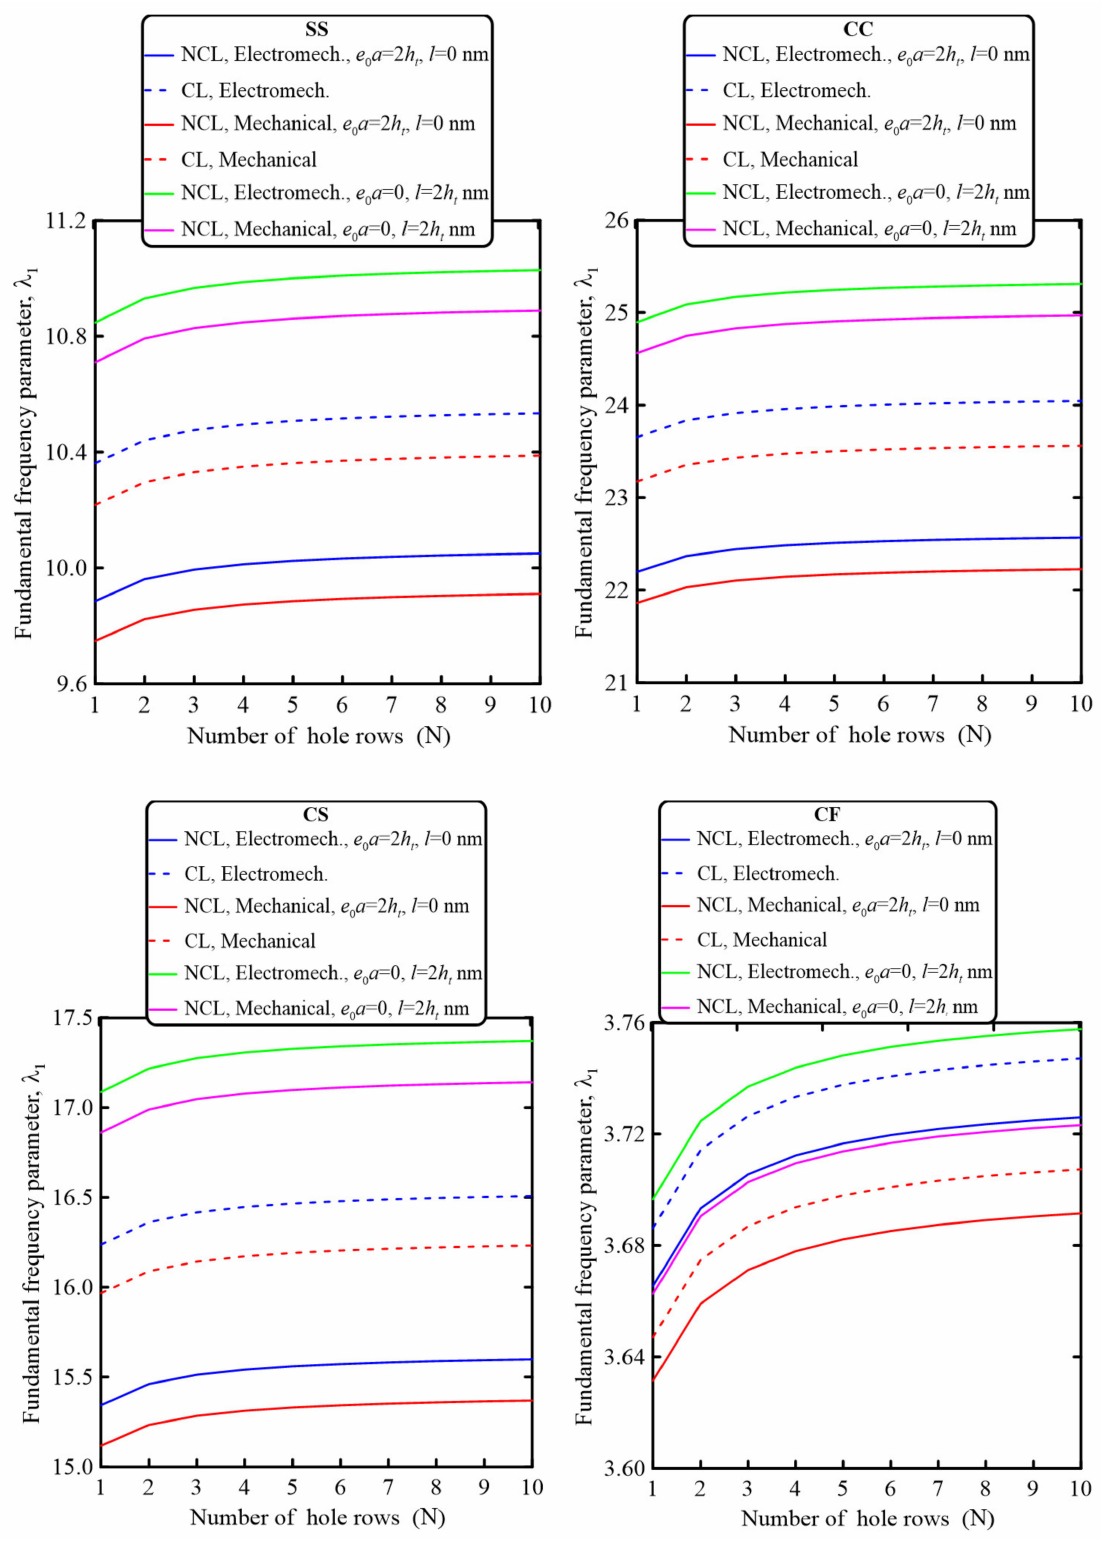
Figure 3. Variation of the fundamental frequency parameter λ 1 with the number of hole rows N for nonclassical and classical electromechanical and mechanical analyses of piezoelectric sandwich nanobeams for different beam boundary conditions at α = 0.5 and beam aspect ratio L / h t = 20 (N = 4, e 0 a = 0 nm, e 311 = − 4.1 C/m 2 , µ 3111 = 5 × 10 − 8 C/m, and a 33 = 7.124 × 10 − 9 C/m 2